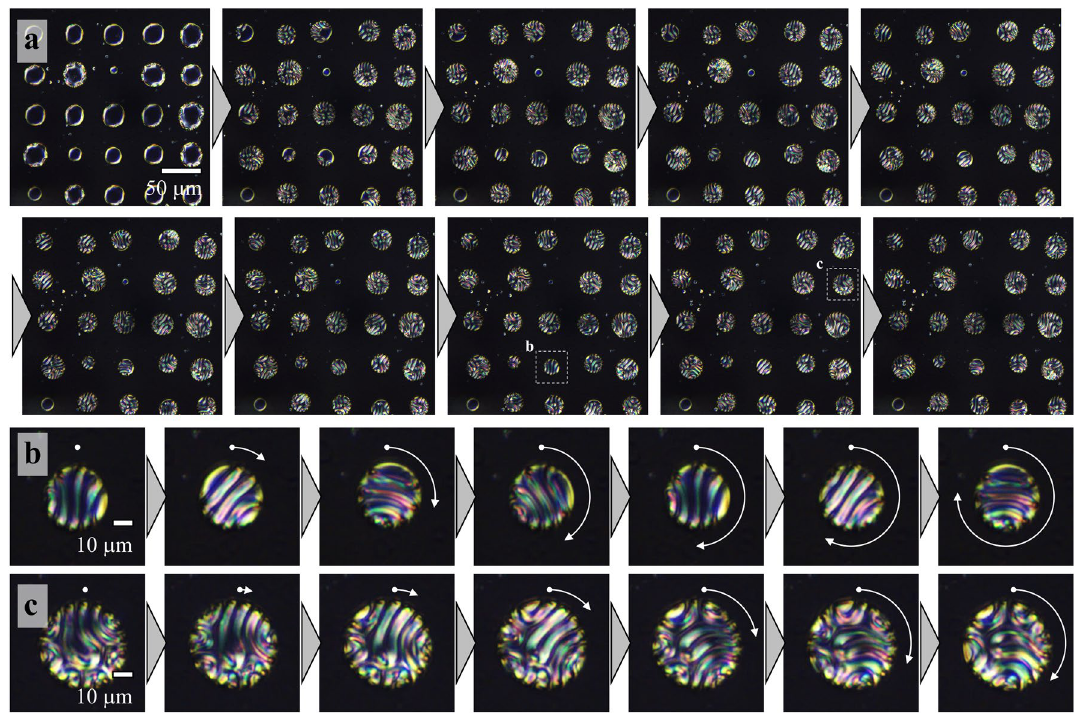
Figure 6. Lehmann rotation of LCD array. (a) Rotational behavior of LCD array (5 × 5) with voltage and ▽ T ~ 5 mK µm −1 after decreasing voltage from 30 to 2.5 V. In the micrographs of LCDs surrounded by white dashed lines in (b) and (c) , white dots and arrows represent the initial position of characteristic texture and rotational angle, respectively. Micrographs were taken every 10